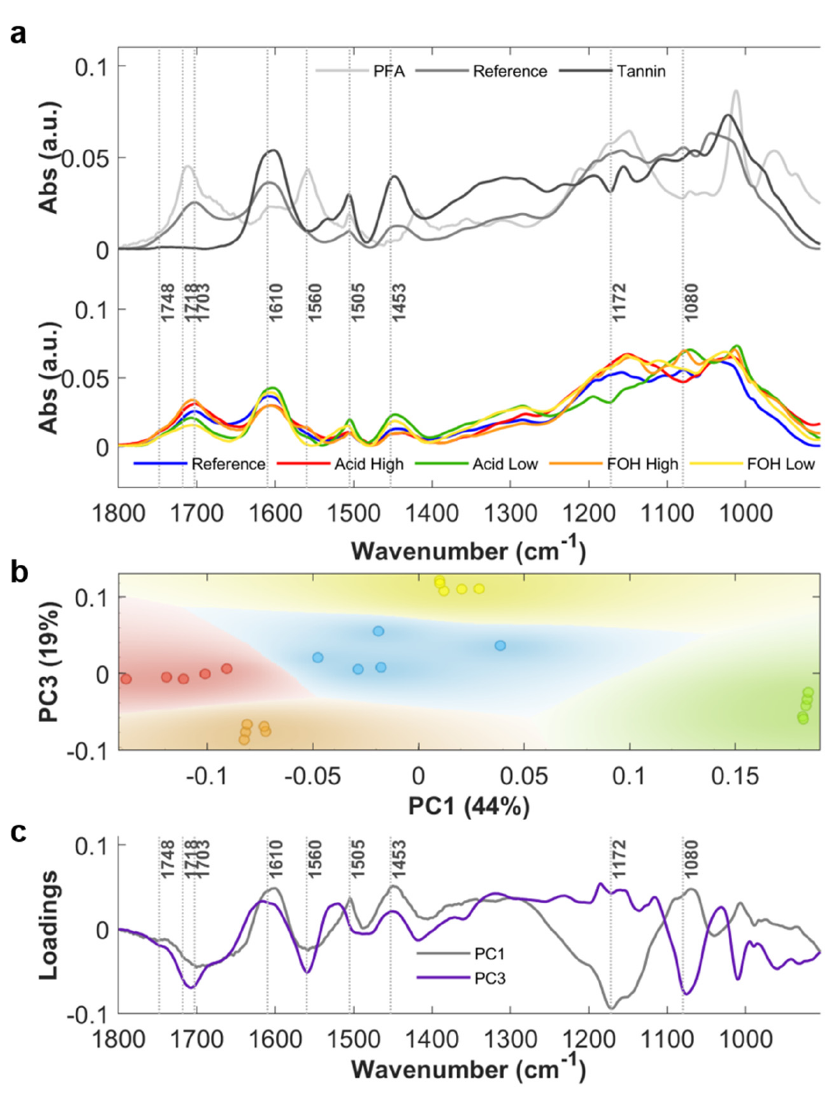
Figure 2. ( a ) Upper panel: Average absorbance spectra ( n = 5) of tannin mimosa extract (Tannin), polyfurfuryl alcohol (PFA) and tannin-furanic reference foam (Reference); Bottom panel: Average absorbance spectra ( n = 5) of tannin-furanic foam formulations: Reference (blue), Acid High (red), Acid Low (green), FOH High (orange) and FOH Low (yellow). ( b ) PC1-PC3 scatter plot. ( c ) PC1 and PC3 loadings, gray and purple lines